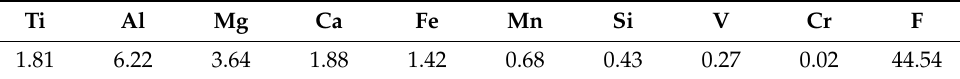
Table 5. Composition of calcinated residue under the conditions of F − concentration at 14 mol/L, leaching temperature of 90 ◦ C for 20 min with L / S ratio of 20:1, and rotating speed of 200 r/min (wt%).